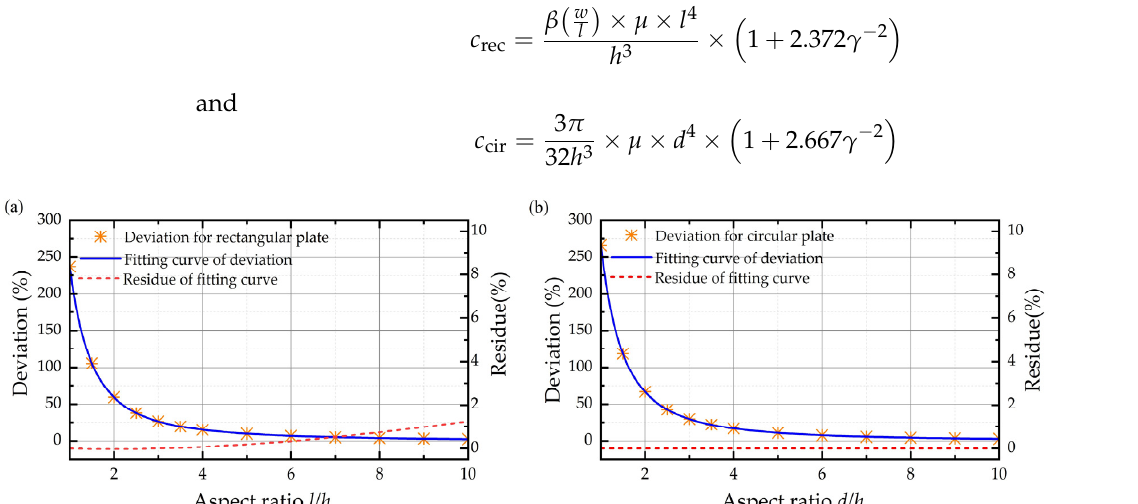
Figure 6. Fitting curve of deviations between the simulation results and theoretical results along with the residue of the fitting curve when the air film thickness is 0.6 mm for the ( a ) rectangular plate and ( b ) circular plate.